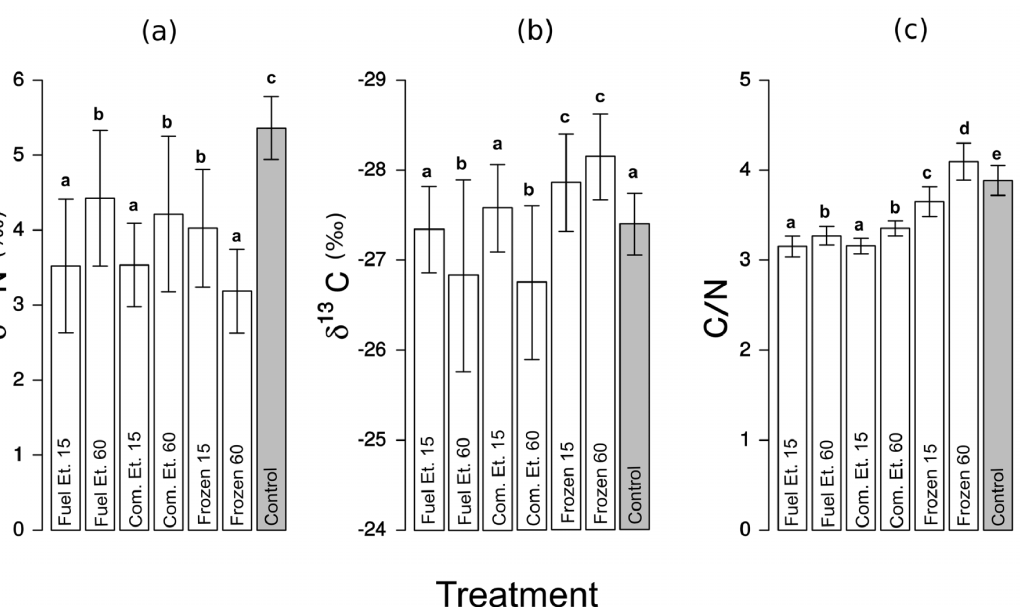
Fig 2. Carbon and nitrogen stable isotope values, and C/N atomic values for Mellopsis doucasae . Mean ± standard deviation of (a) δ 15 N, (b) δ 13 C, and (c) C/N atomic values from the following treatments: Fuel Et. 15 — preserved in fuel ethanol for 15 days; Fuel Et. 60 — preserved in fuel ethanol for 60 days; Com.Et. 15 — preserved in 92.8% commercial ethanol for 15 days; Com.Et. 60 — preserved in 92.8% commercial ethanol for 60 days; Frozen 15 — frozen for 15 days; Frozen 60 — frozen for 60 days; Control — freshly processed material (highlighted in gray). Different letters indicate significant differences between treatment groups (P < 0.05). All preservation methods resulted in significant 15 N depletion compared to controls.